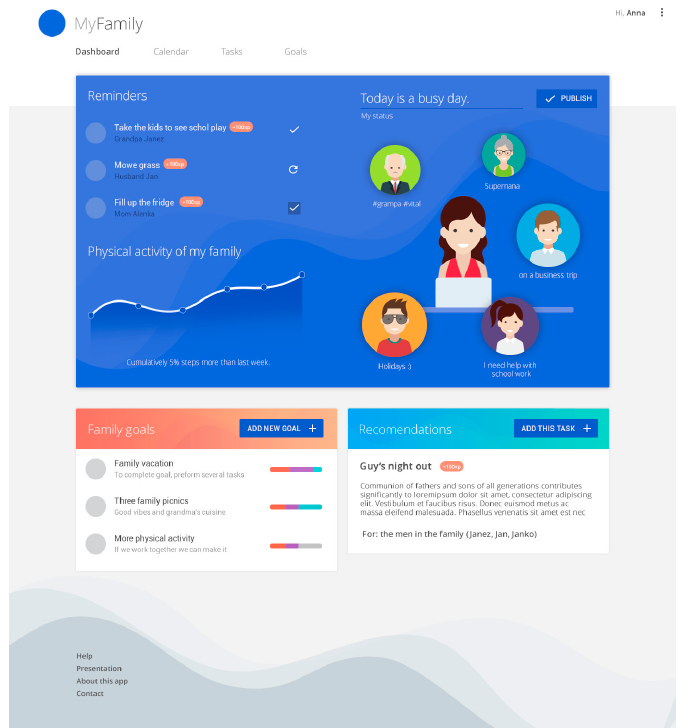
Figure A1. User interface of an interactive prototype solution translated into English. Table A1. Prototype application user testing: Task completion time results.